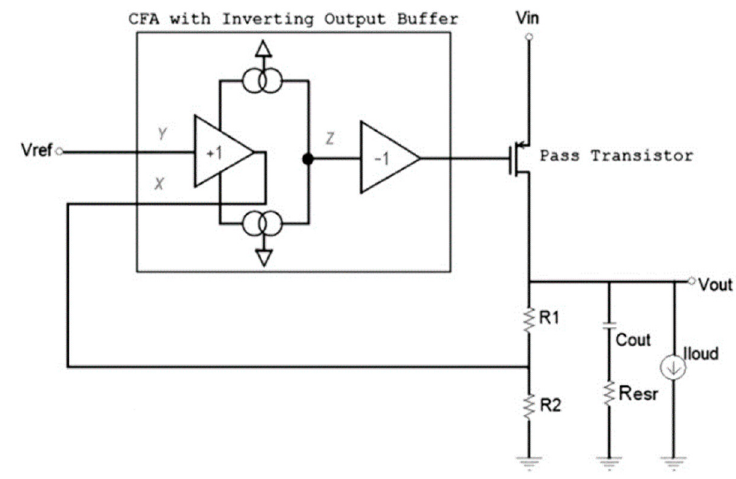
Figure 10. LDO architecture based on CFA [23].